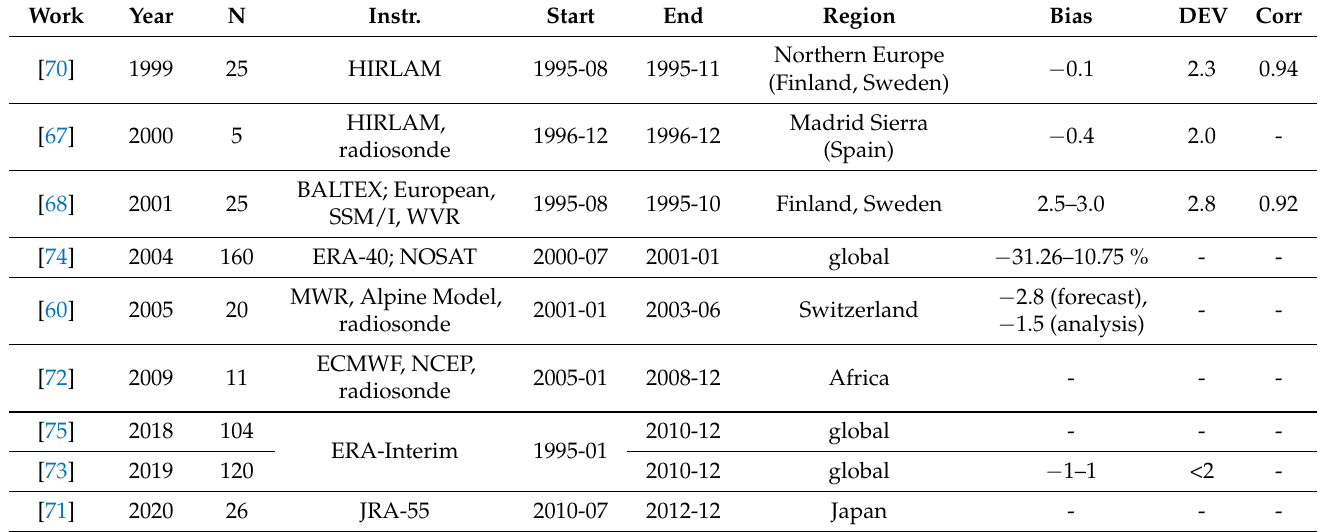
Table 2. Summary of studies on validation of NWP data. Column Year is the publication year. N is the number of stations. Instr. is the instruments (besides ground-based GNSS) used in the study. Start and End mark the period considered in the study, in year-month format. Bias is the bias in mm, and DEV is the RMSE or SD also in mm. Corr is the correlation coefficient